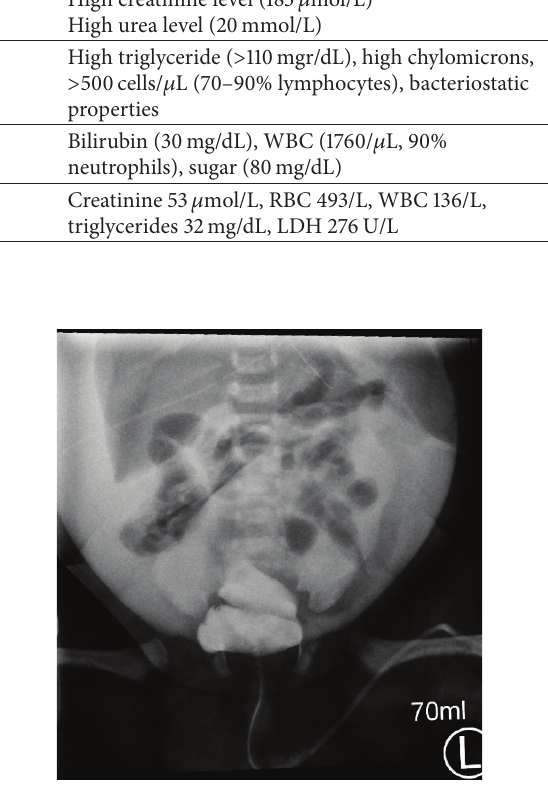
Figure 2: Cystourethrogram indicating intraperitoneal bladder